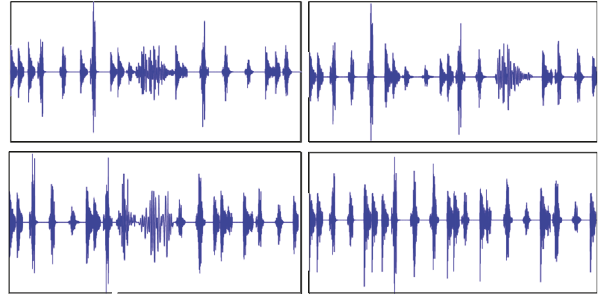
Figure 2: Partial signal data from sample